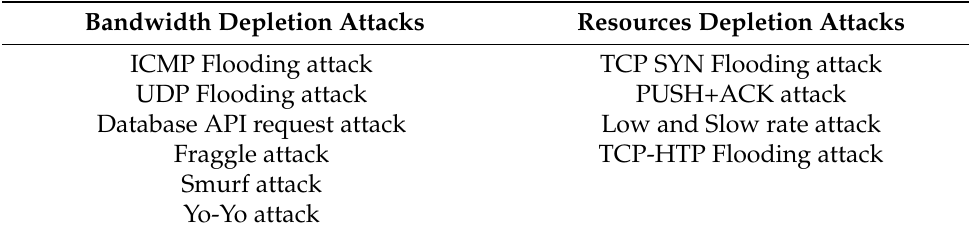
Table 1. Common types of EDoS